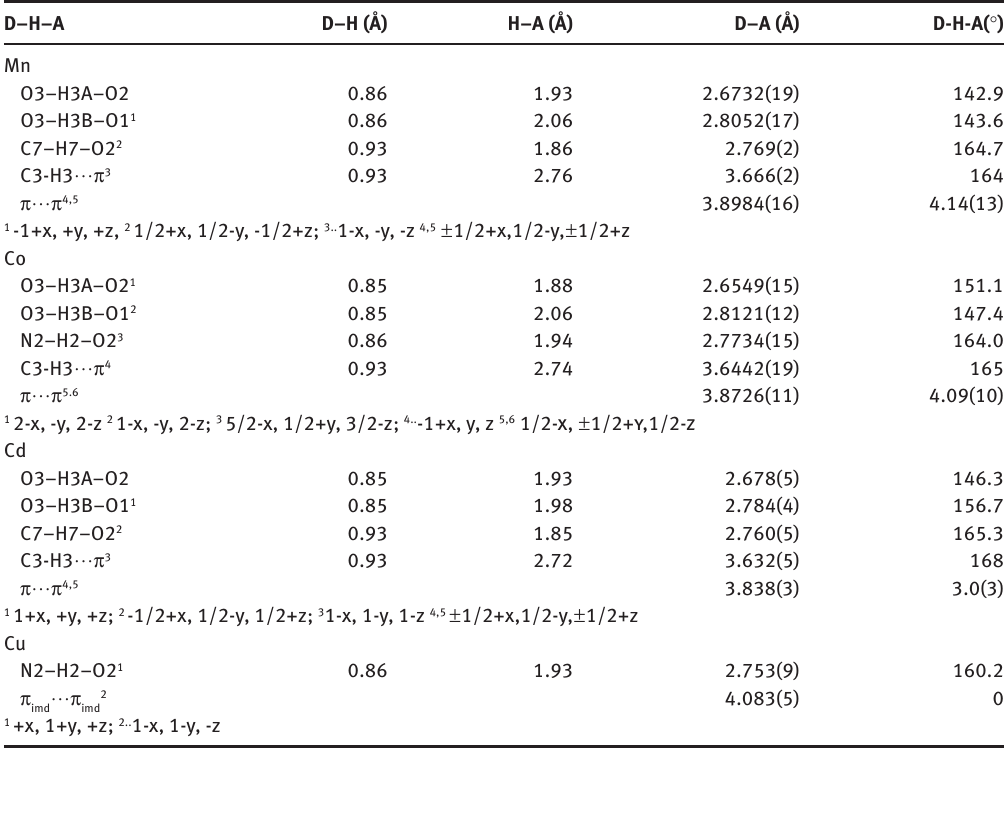
Table 3 Geometries of intermolecular and intramolecular interactions.